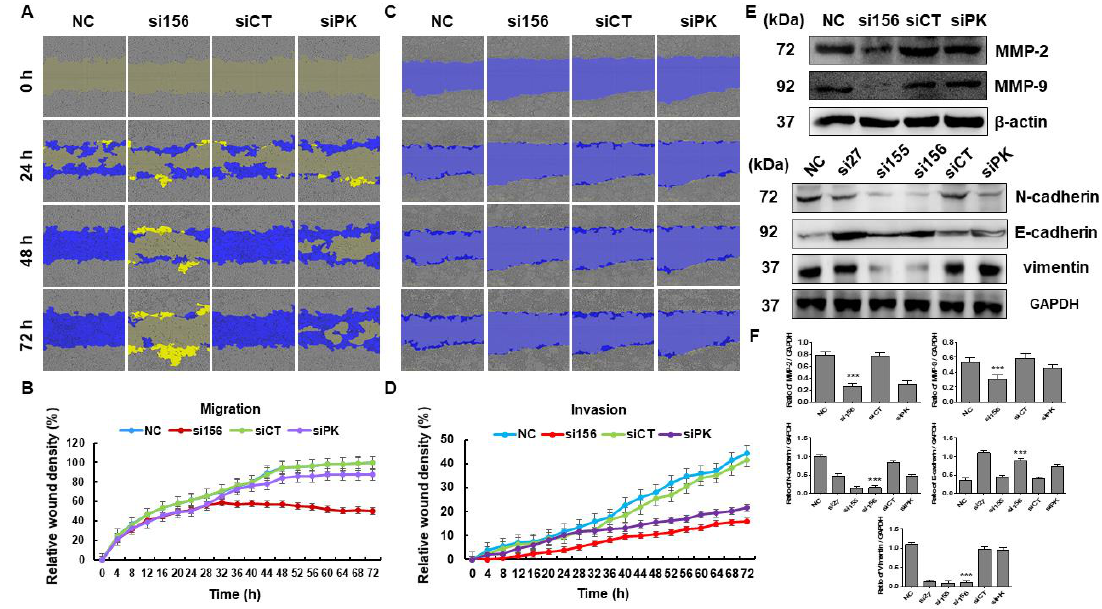
Figure 4. Effects of PKM2 knockdown on migration and invasion of 786-O cells. ( A ) A wound was formed and migration of 786-O cells was measured every day using a phase-contrast microscope for 72 h. ( B ) Mean relative wound density (migration) from three replicate experiments is shown. ( C ) Invasion was assessed in control and PKM2-knockdown cells. ( D ) Mean relative wound density (invasion) from three replicate experiments is shown. ( E ) Cells were harvested and whole cell lysates were examined by Western blotting using antibodies specific for matrix metalloproteinase (MMP)-2, MMP-9, N-cadherin, E-cadherin, and vimentin. GAPDH was used as internal loading control. ( F ) Band intensities were measured and plotted as a bar graph relative to GAPDH level. One-way ANOVA was used to compare means of different groups. Differences between means were considered significant at p < 0.05 using Tukey’s multiple comparison test; *** p < 0.001 as compared with normal control cells.